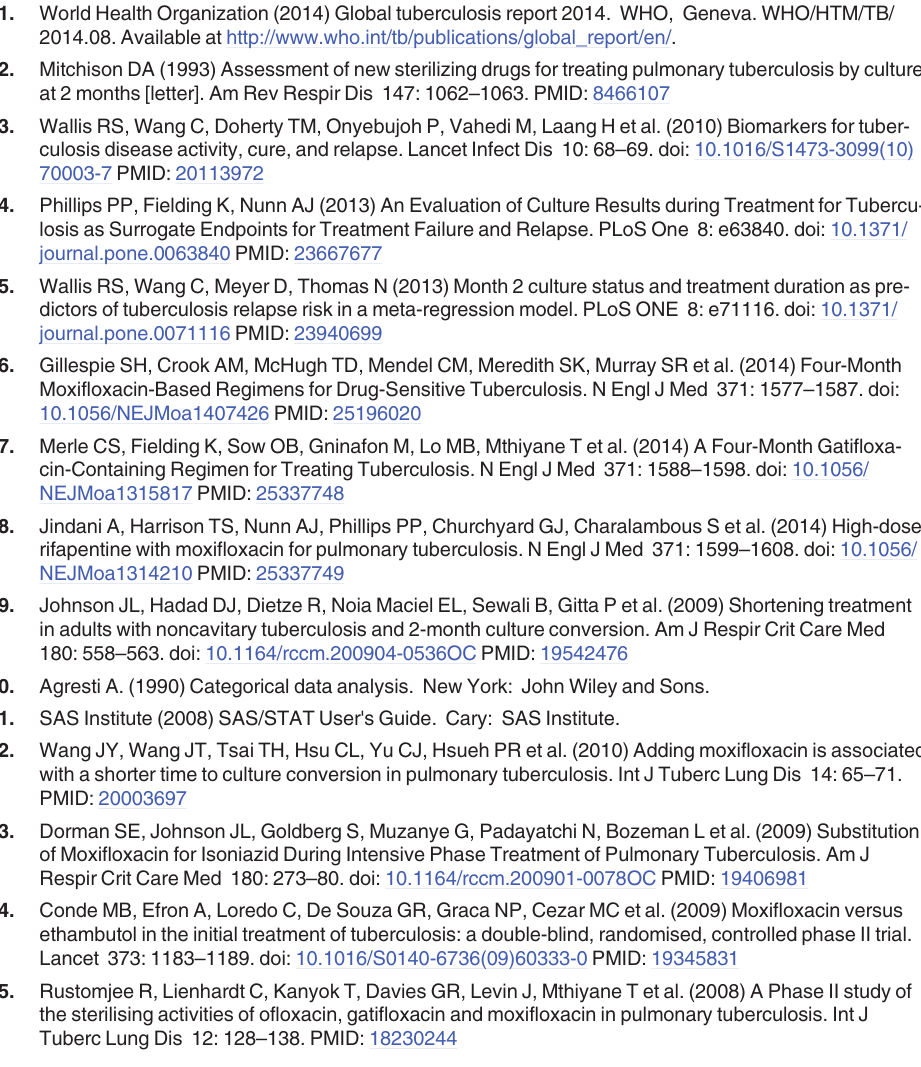
S3 Fig. Diagnostic plots of standardized residuals for logit relapse rates. A) Predicted values vs. residuals, B) Histogram of residuals and C) Q-Q plot of residuals.